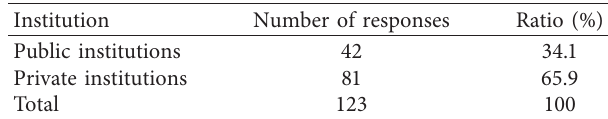
Table 6: Distribution of student responses by type of institution.